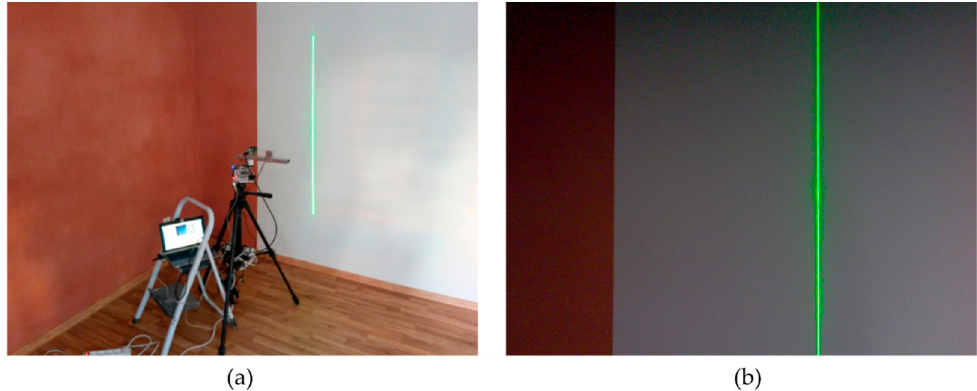
Figure 16. Measurement illustration: ( a ) Developed 3D scanner; ( b ) Measurement frame.